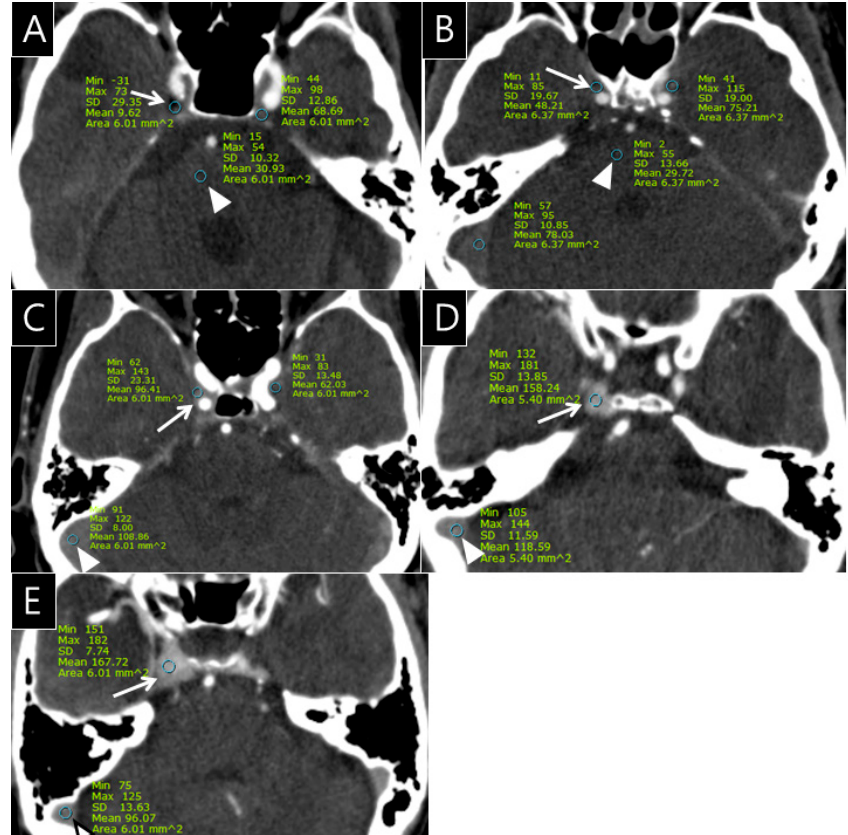
Figure 1. Examples of the 5-point grading scale for the cavernous sinus (CS) on computed tomography angiography (CTA); ( A ), Grade 0: Opacification of the right CS (arrow, CT number: 9.6 HU) is less than or equal to the density of the pons (arrowhead, CT number: 30.9 HU) on the CTA source image; ( B ), Grade I: Opacification of the right CS (arrow, CT number: 48.2 HU) is greater than the density of the pons (arrowhead, CT number: 29.7 HU) on the CTA source image; ( C ), Grade II: Opacification of the right CS (arrow, CT number: 96.4 HU) is less than or equal to that of transverse sinus (arrowhead, CT number: 108.8 HU) on the CTA source image; ( D ), Grade III: Opacification of the right CS (arrow, CT number: 158.2 HU) is greater than that of the transverse sinus (arrowhead, CT number: 118.6 HU) in less than or equal to one-third of the CS; ( E ), Grade IV: Opacification of the right CS (arrow, CT number: 167.7 HU) is seen in more than one-third of the CS (arrowhead, CT number of transverse sinus: 96.1 HU).